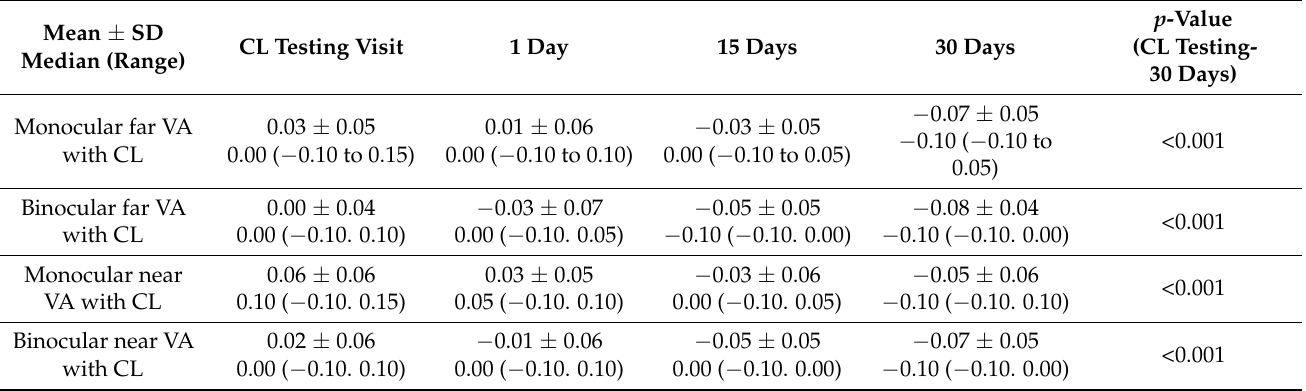
Table 2. Visual acuity data measured at the different visits of the current clinical study. Abbreviations: SD, standard deviation; CL, contact lens; VA, visual